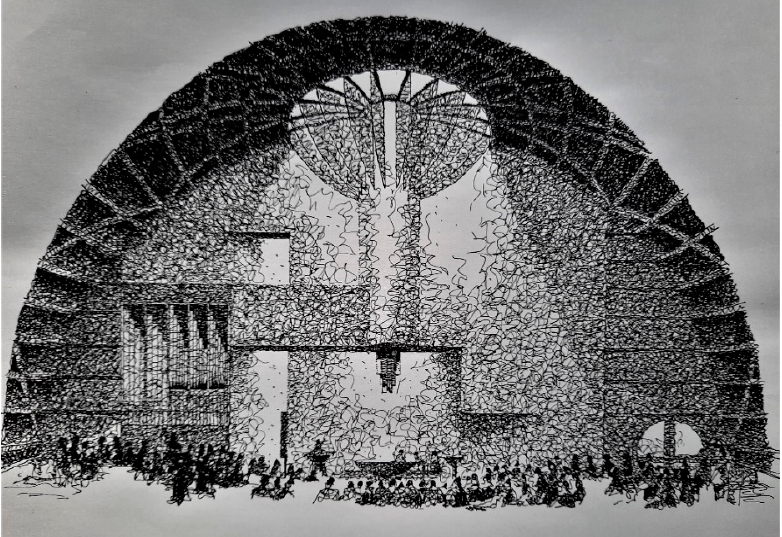
Figure 6. Justus Dahinden’s undated pen sketch representing the symbolic light entering through the skylight positioned above the altarpiece (parish archive, Varese).